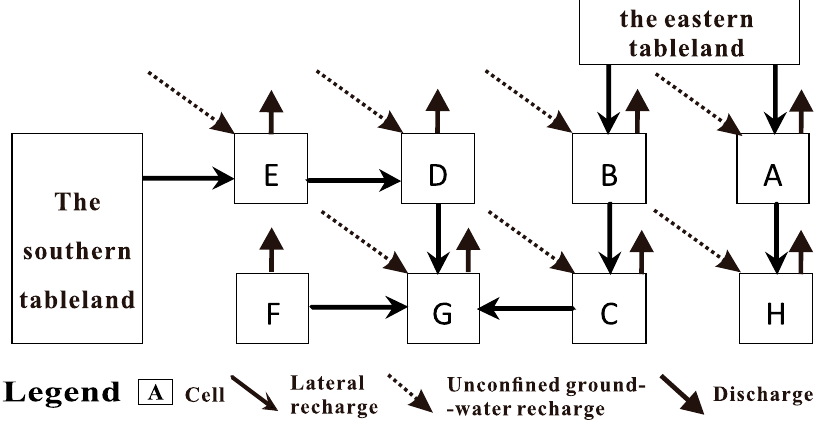
Figure 11. Relationships between the cells.